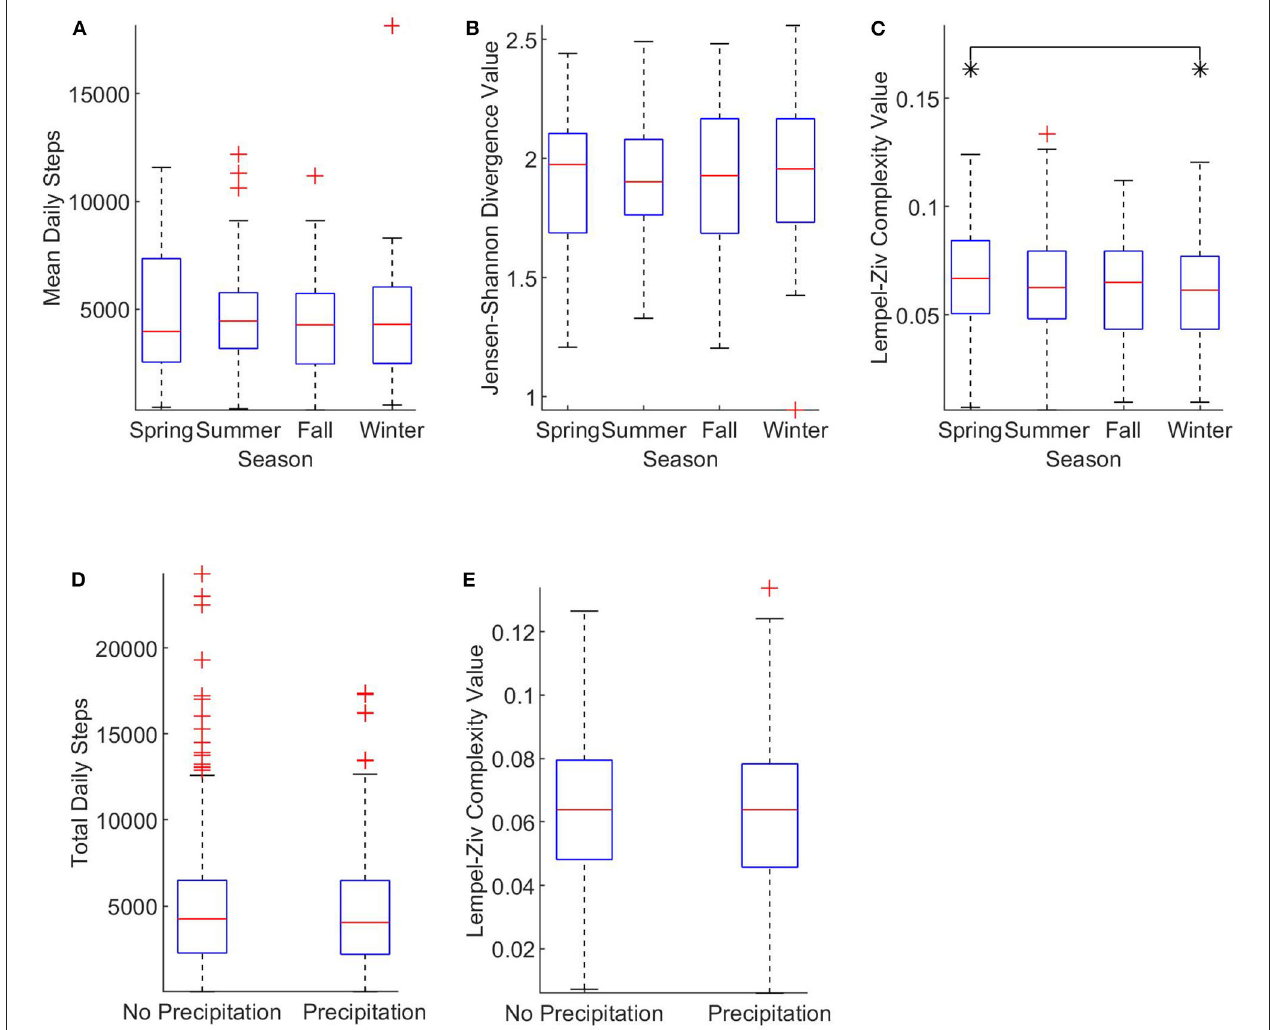
FIGURE 3 | The effect of weather on linear and nonlinear physical activity measures. (A) Shows the effect of season on mean daily steps ( n = 142). (B) Compares JSD values by season ( n = 142). (C) Shows the effect of season on daily LZC values ( n = 852). (D) Shows the effect of precipitation on total daily steps ( n = 852). (E) Categorizes daily LZC values by precipitation presence ( n = 852). All data is plotted on standard box and whisker plots with outliers notated with crosses ( + ). The edges of brackets annotated with an asterisk (*) indicate significant between-group differences, p < 0.05.